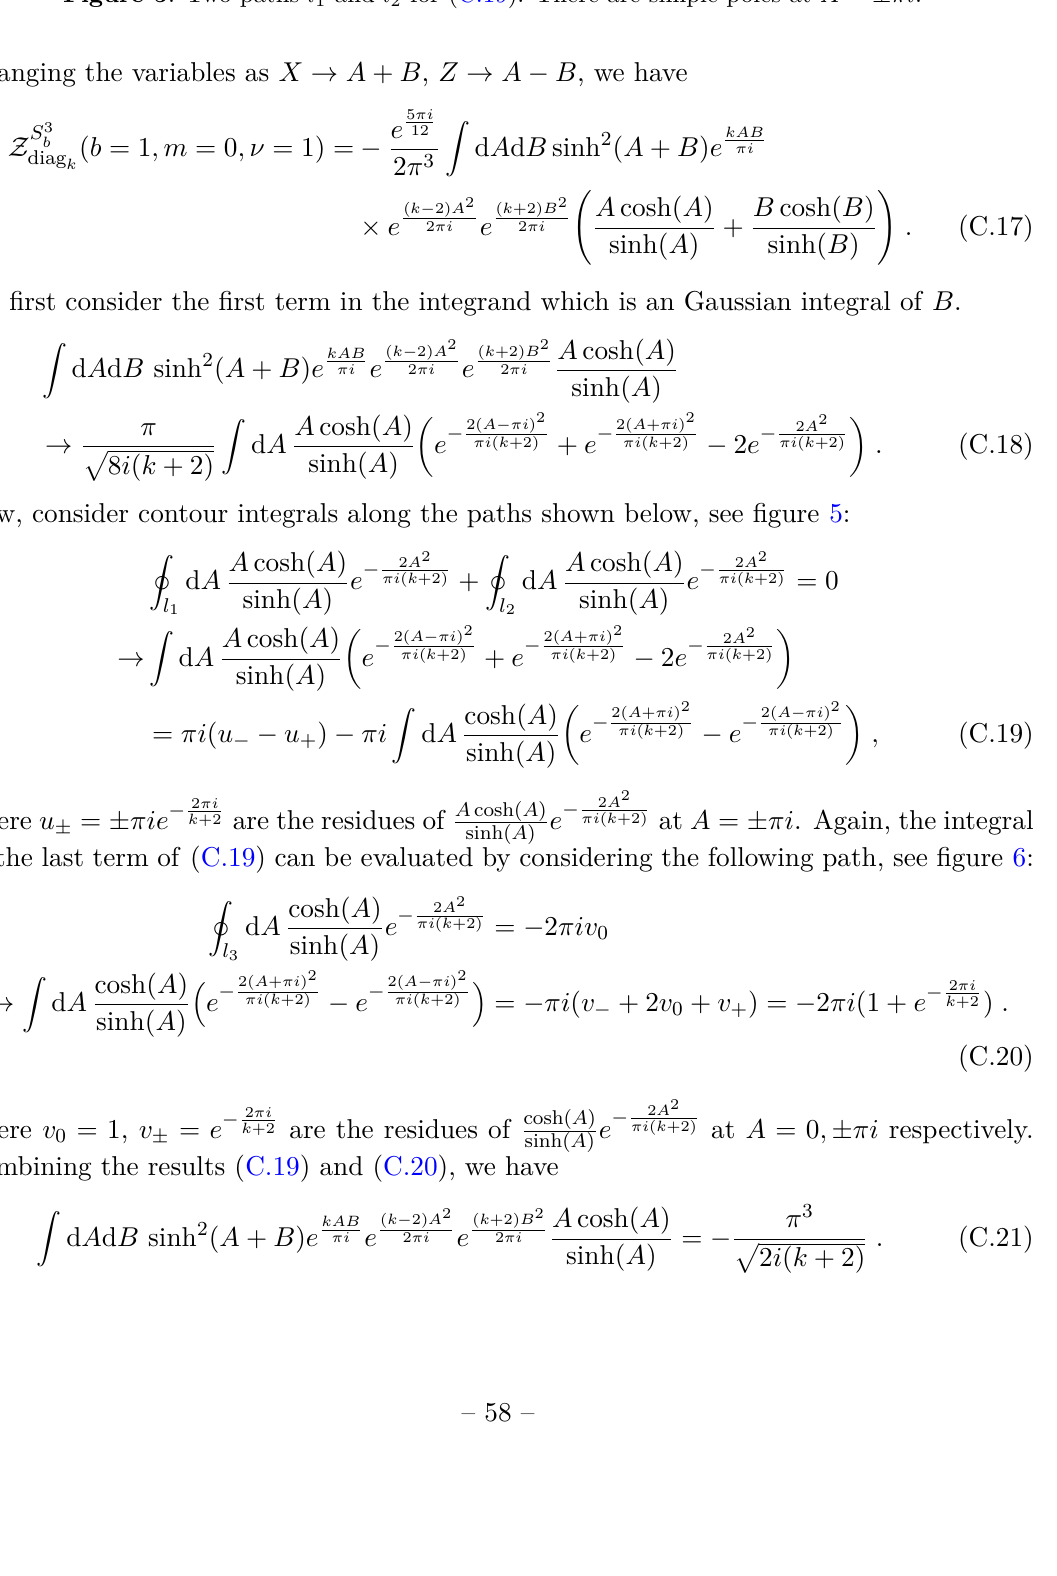
Figure 5 . Two paths l 1 and l 2 for (C.19). There are simple poles at A = ± πi